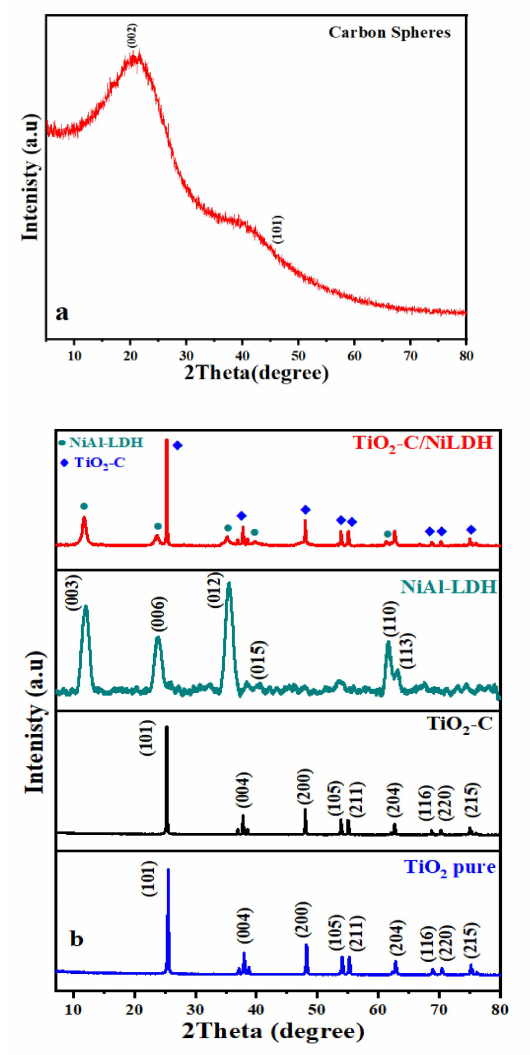
Figure 2. X-ray diffraction (XRD) patterns of ( a ) carbon spheres and ( b ) TiO 2 , TiO 2 -C, NiAl-LDH, and TiO 2 -C/NiLDH